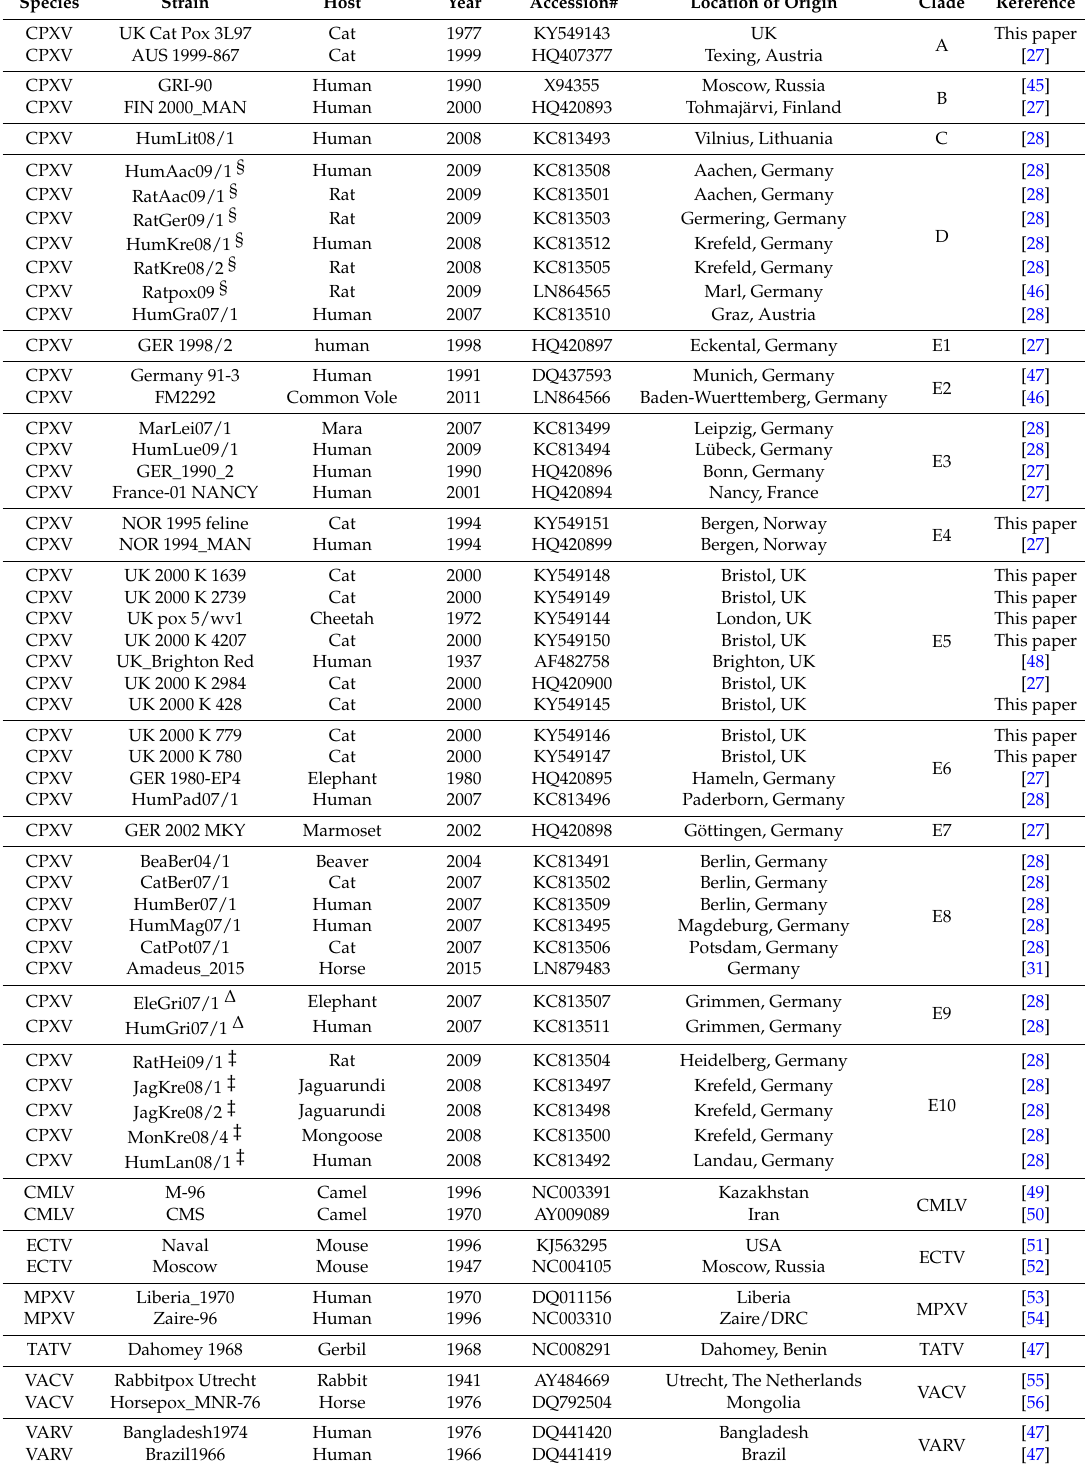
Table 1. Table of all orthopoxvirus strains examined in the phylogenetic analyses including species, strain name, host (organism from which virus was extracted), year of isolation, GenBank accession number, locality data, clade within the MrBayes topologies, and original genome references. Isolates with identical symbols ( § , ∆ , ‡ ) are from the same outbreak or are otherwise linked epidemiologically.